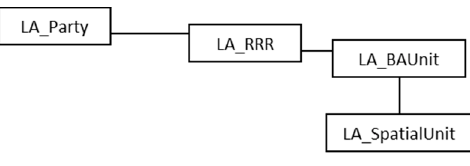
Figure 9. The space subdivisions of PC2 (second epoch) after the change. The purple wall in the right image shows the intersection of a detected change with a space subdivision.